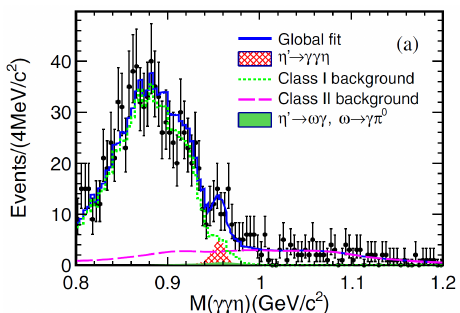
Figure 4: γγη invariant mass distribution in η (cid:48) signal region. The black dots with error bars are data, the blue line is the global fit result, the shaded histogram is signal, and the others are backgrounds. The plot is reproduced from Ref [ 20 ] under the Creative Commons Attribution 4.0 International license.